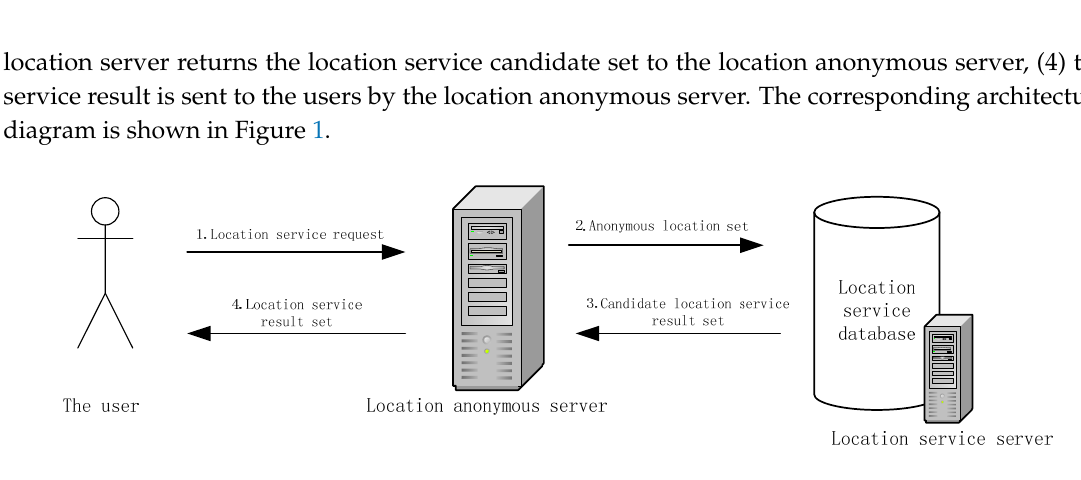
Figure 1. The diagram of centralized location service.